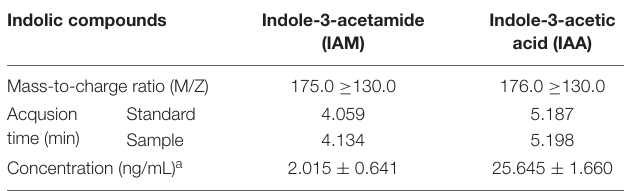
TABLE 4 | HPLC-MS/MS analysis of indole-3-acetamide (IAM) and indole-3-acetic acid (IAA) in protein